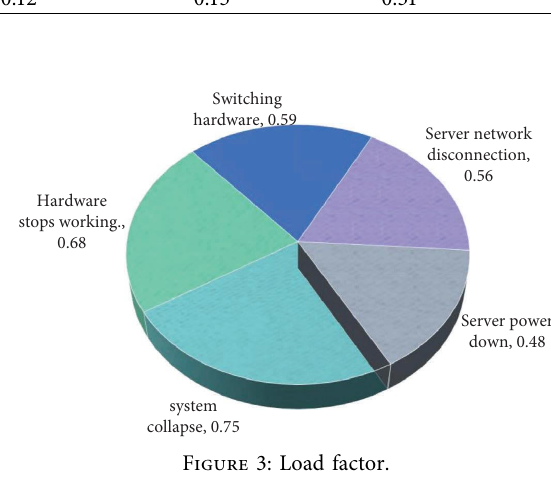
Figure 3: Load factor.